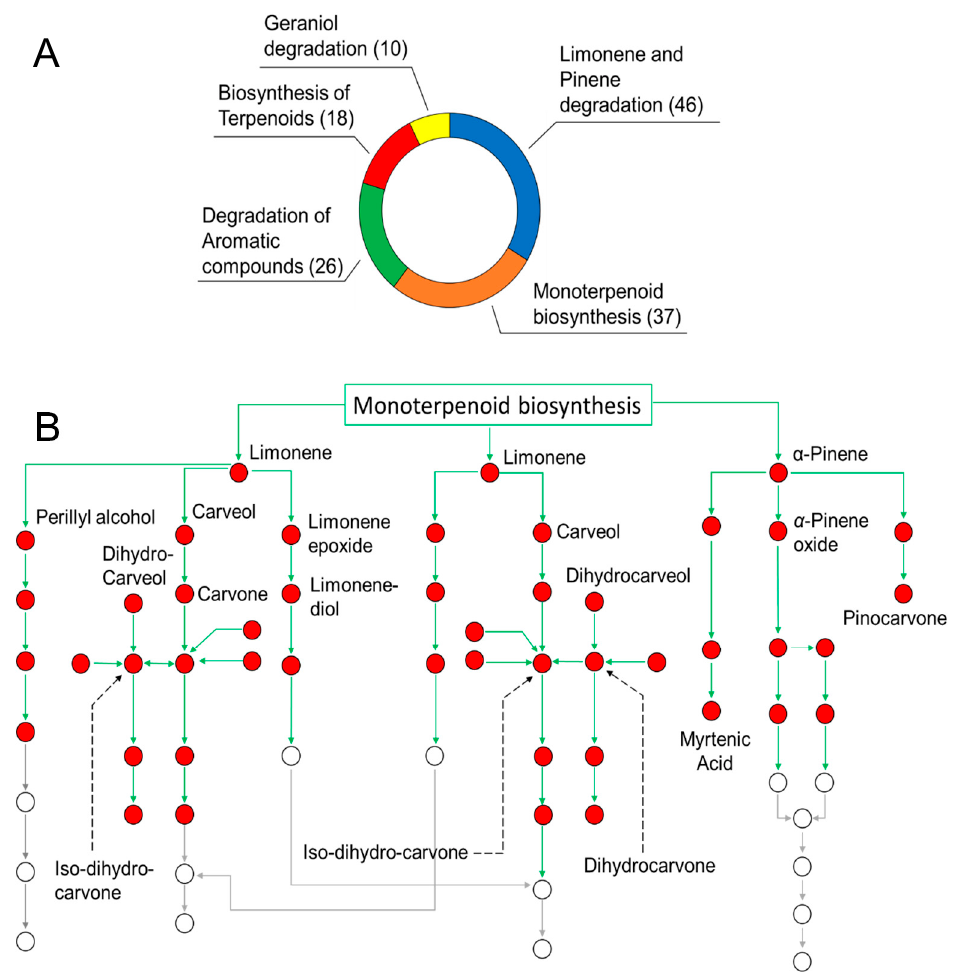
Figure 1. (Panel A ): Donut chart for the most populated biological pathways in SEO. Numbers of identified hits in each path are reported in brackets. (Panel B ): Connection network of “limonene and pinene degradation” starting from monoterpenoid biosynthesis among annotated metabolites in SEO.